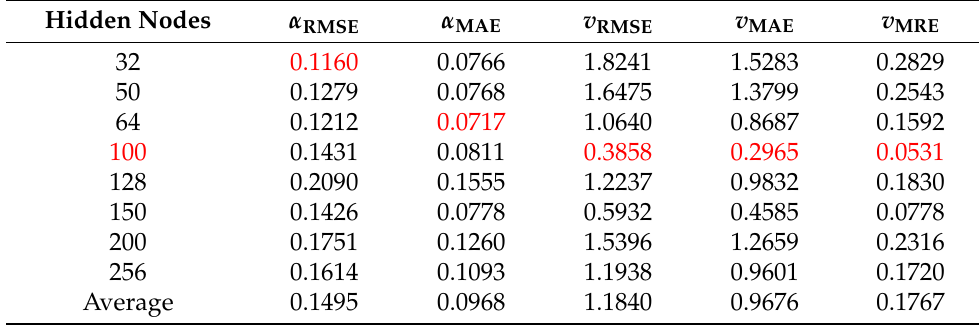
Table 6. Prediction results of different hidden nodes in a layer.